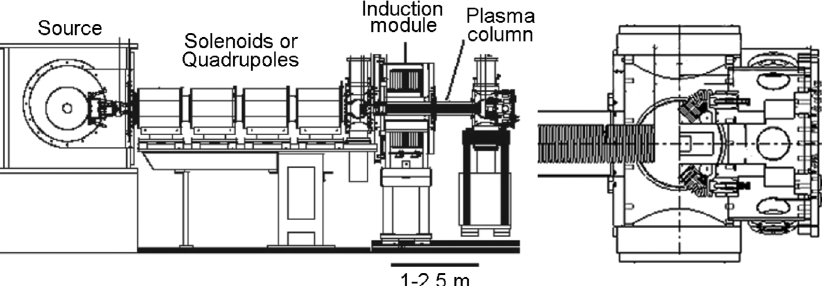
FIG. 2. Schematic of the NDCX device (left) and close-up drawing of the end of the plasma column and diagnostic box region (right). The two cathodic-arc source filter coils are angled at (cid:3) (cid:6) (cid:3) (cid:2)= 4 radians relative to the guide solenoid. The drift tube and guide solenoid can extend from 1–2.5